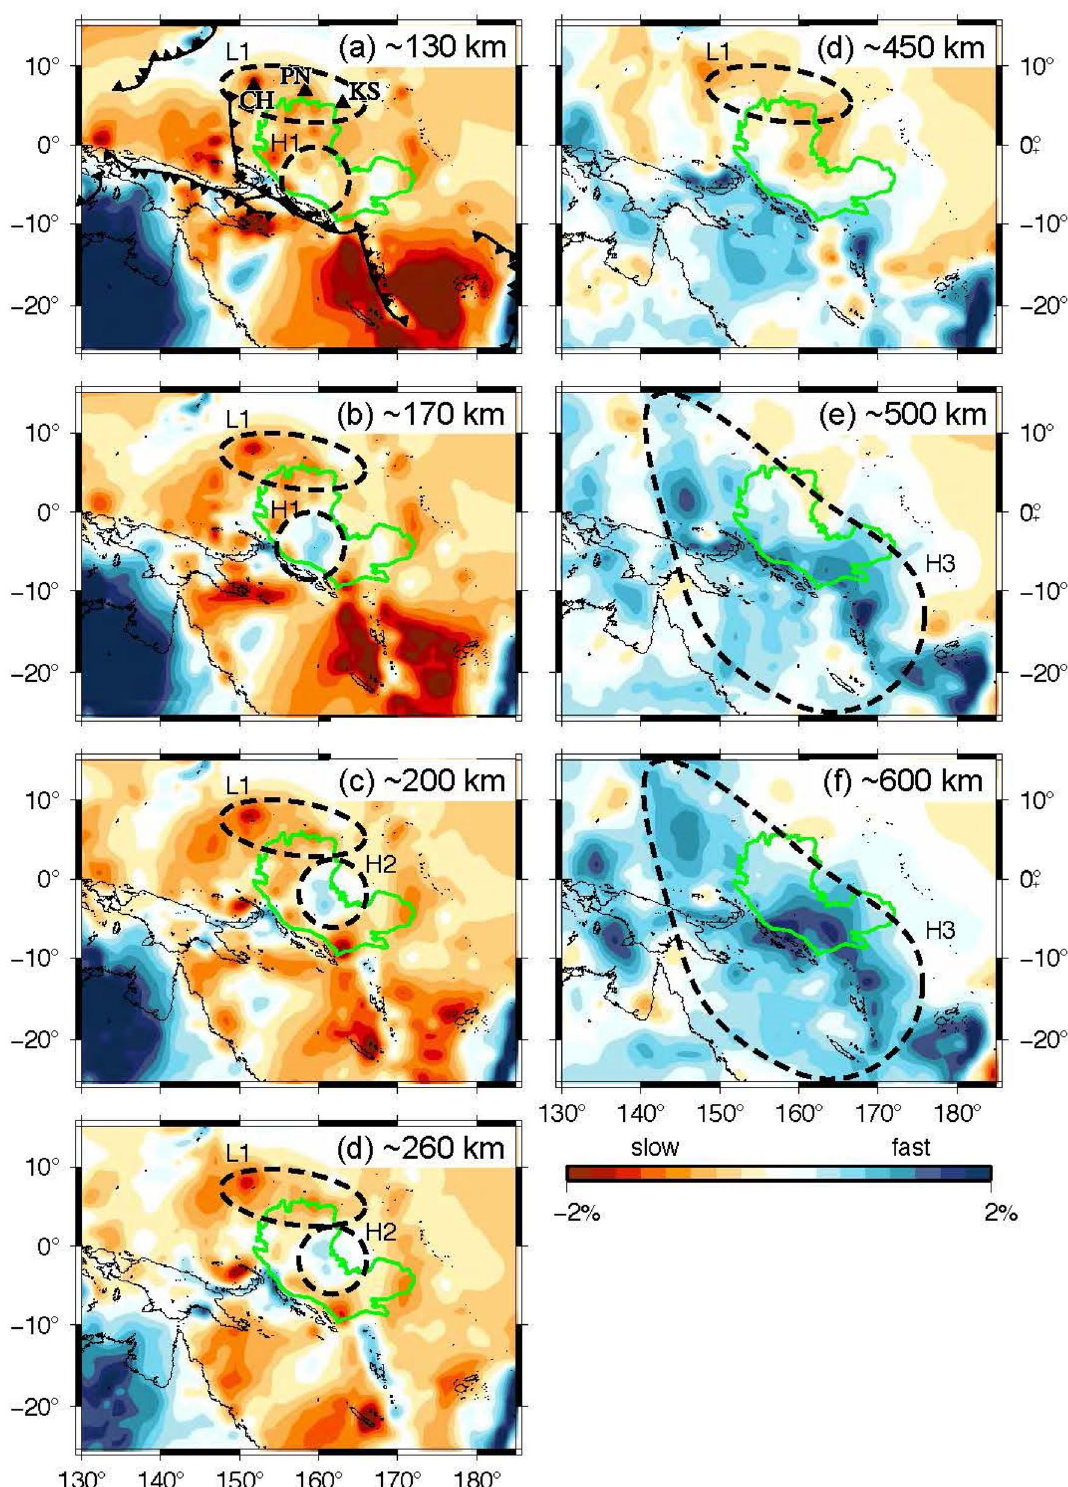
Figure 2. P-wave velocity anomalies at depths of approximately ( a ) 130 km, ( b ) 170 km, ( c ) 200 km, ( d ) 260 km, ( e ) 450 km, ( f ) 500 km, and ( f ) 600 km in the region indicated by thick lines in Fig. 1. The OJP is represented by the green line on each panel. Present subduction boundaries are shown in ( a ). H–H3 and L1 indicate regions of high velocity anomalies and low velocity anomalies discussed in the text, respectively. The GMT 5.4.5 53 was used to make this